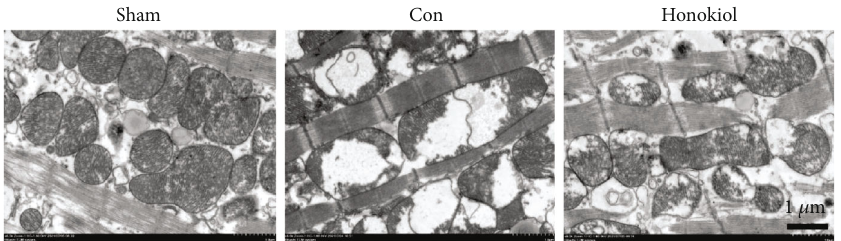
Figure 5: Analysis of cardiomyocytes via electron microscopy. MI/RI resulted in the damage of the myocardial ultrastructure and mitochondrial in fl ammation, which was attenuated after melatonin treatment ( n = 3 for each cohort). Black arrow: mitochondria. Original magni fi cation: 15000x.